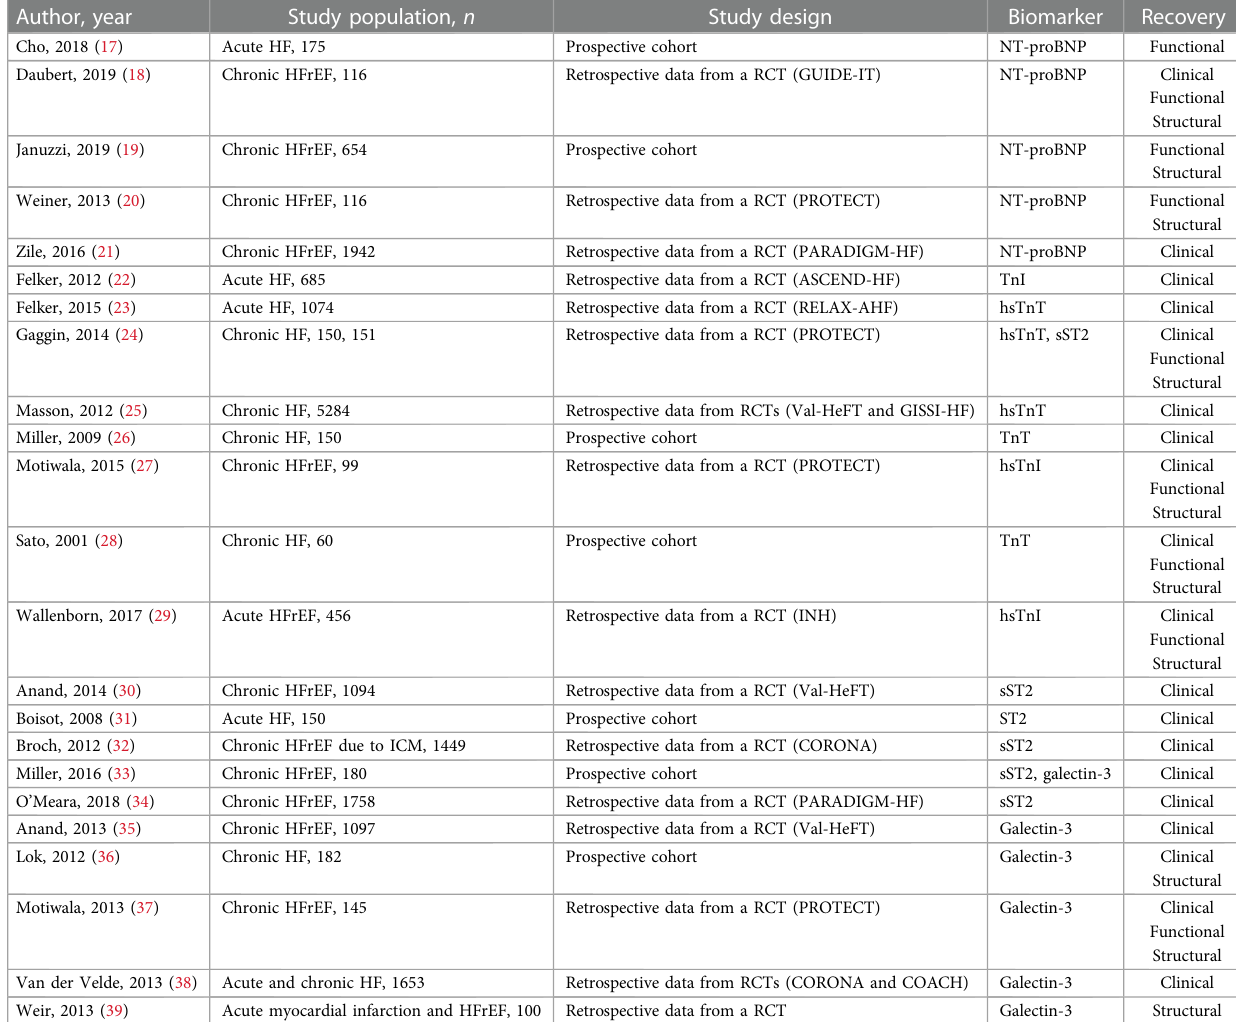
TABLE 1 Studies evaluating biomarker monitoring to predict structural, functional, and/or clinical recovery in HF patients. Author,